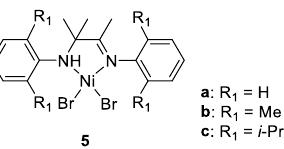
Figure 4. Amine – imine nickel complexes with different substituted anilines.